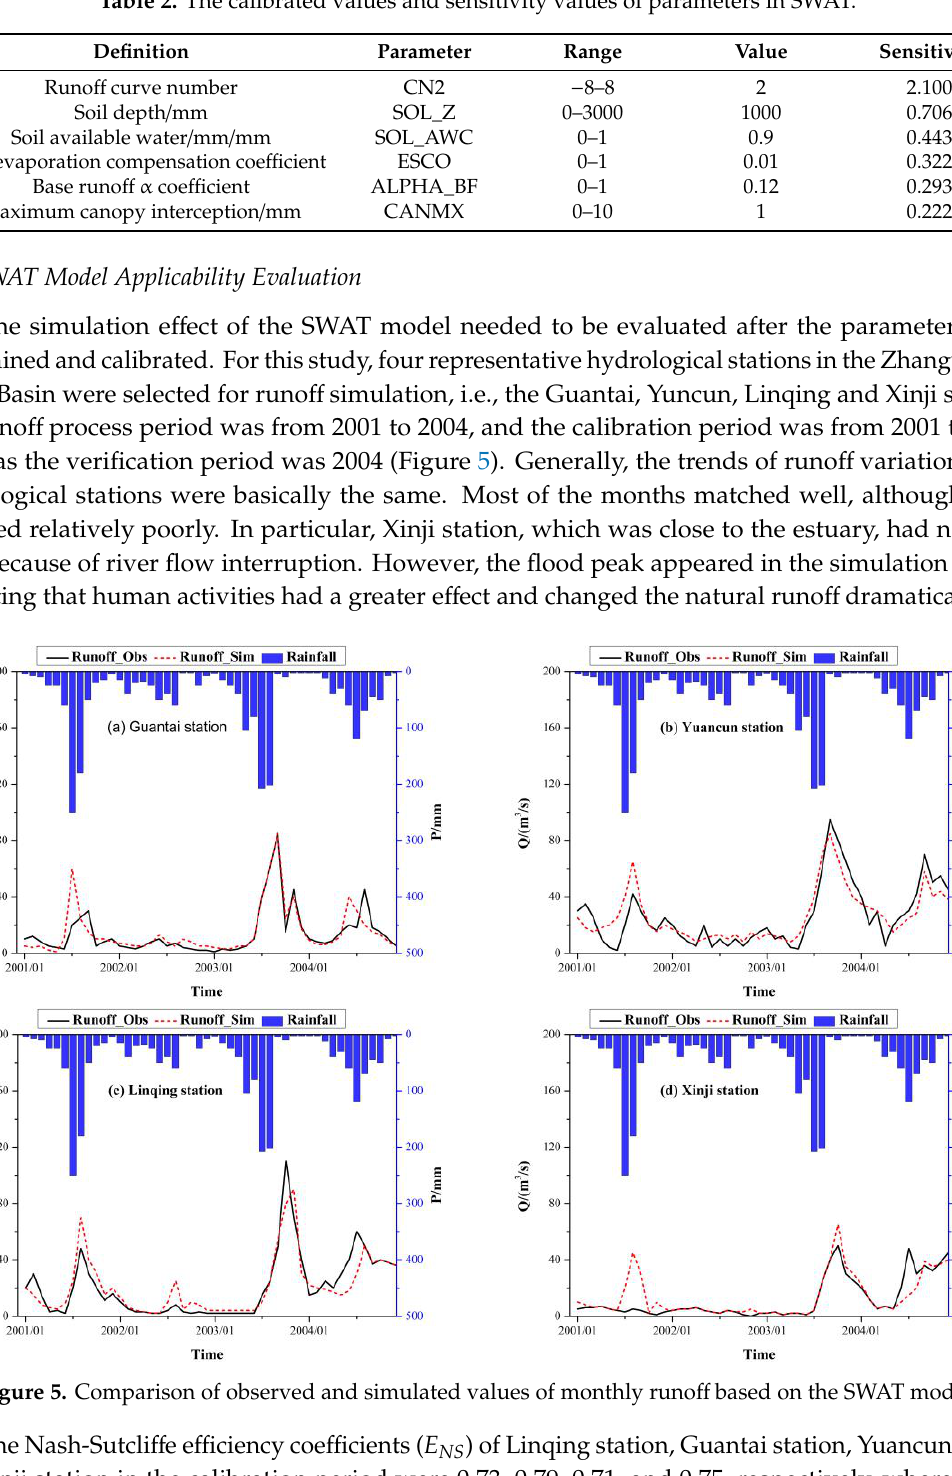
Table 2. The calibrated values and sensitivity values of parameters in SWAT.